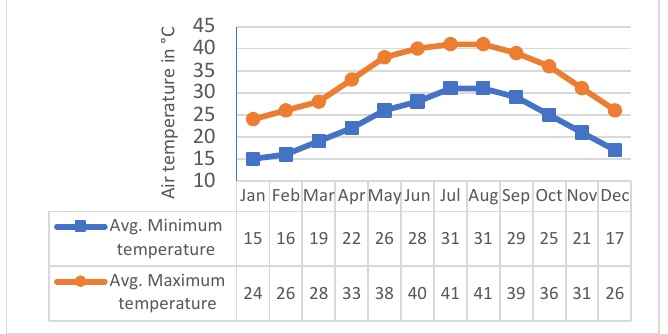
Figure 5. The average monthly air temperature in Dubai, UAE. Graph generated by the author from reference [42].